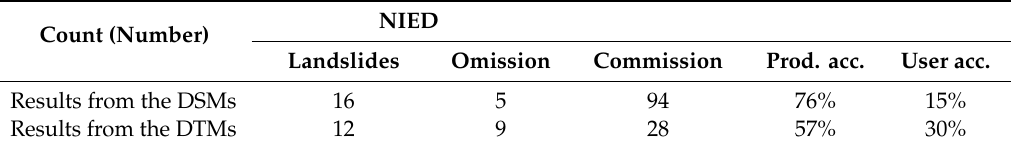
Table 3. Comparison of the detected results with the landslides identified by NIED.